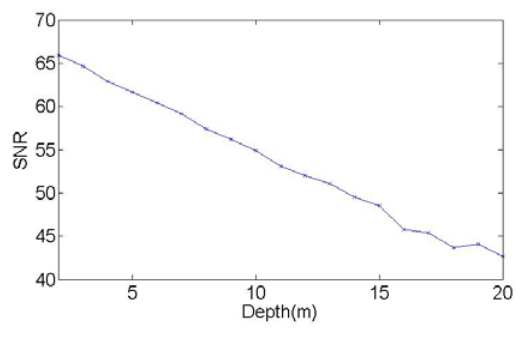
Fig.2 SNR of the bottom returned waveform vs. water depth